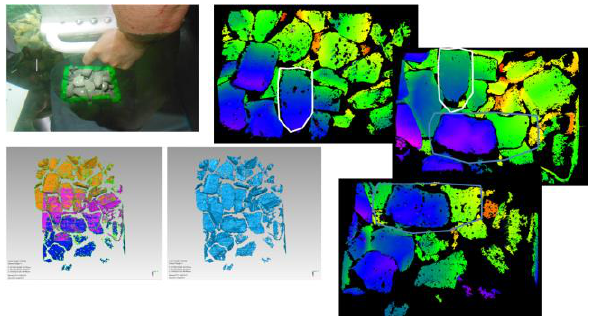
Figure 13. Example underwater measurement stones with several 3D representations and identification of the same objects in different